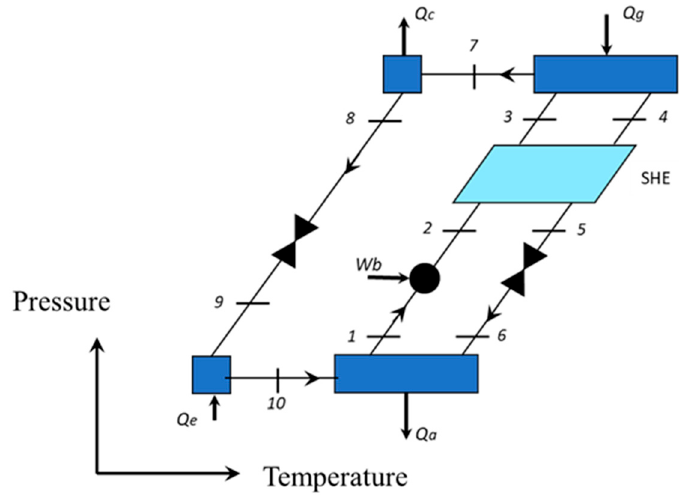
Figure 1. Schematic diagram of a single-effect absorption cooling system.